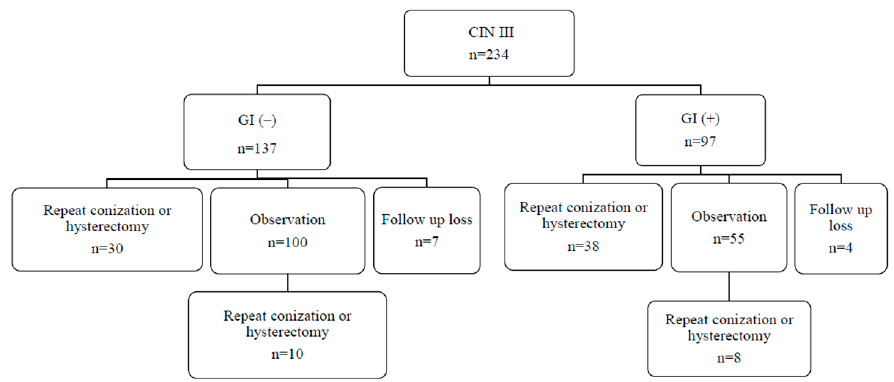
Figure 1. Clinical management according to the glandular involvement status. Treatment outcomes were compared between the GI-negative and GI-positive groups (Table 2). There were no significant differences in age, parity, menopause, high-risk HPV infection, and persistent HPV infection. Although surgical MI was not significantly different ( p = 0.051), repeat conization or hysterectomy within 6 months was performed significantly more in the GI-positive group ( p =